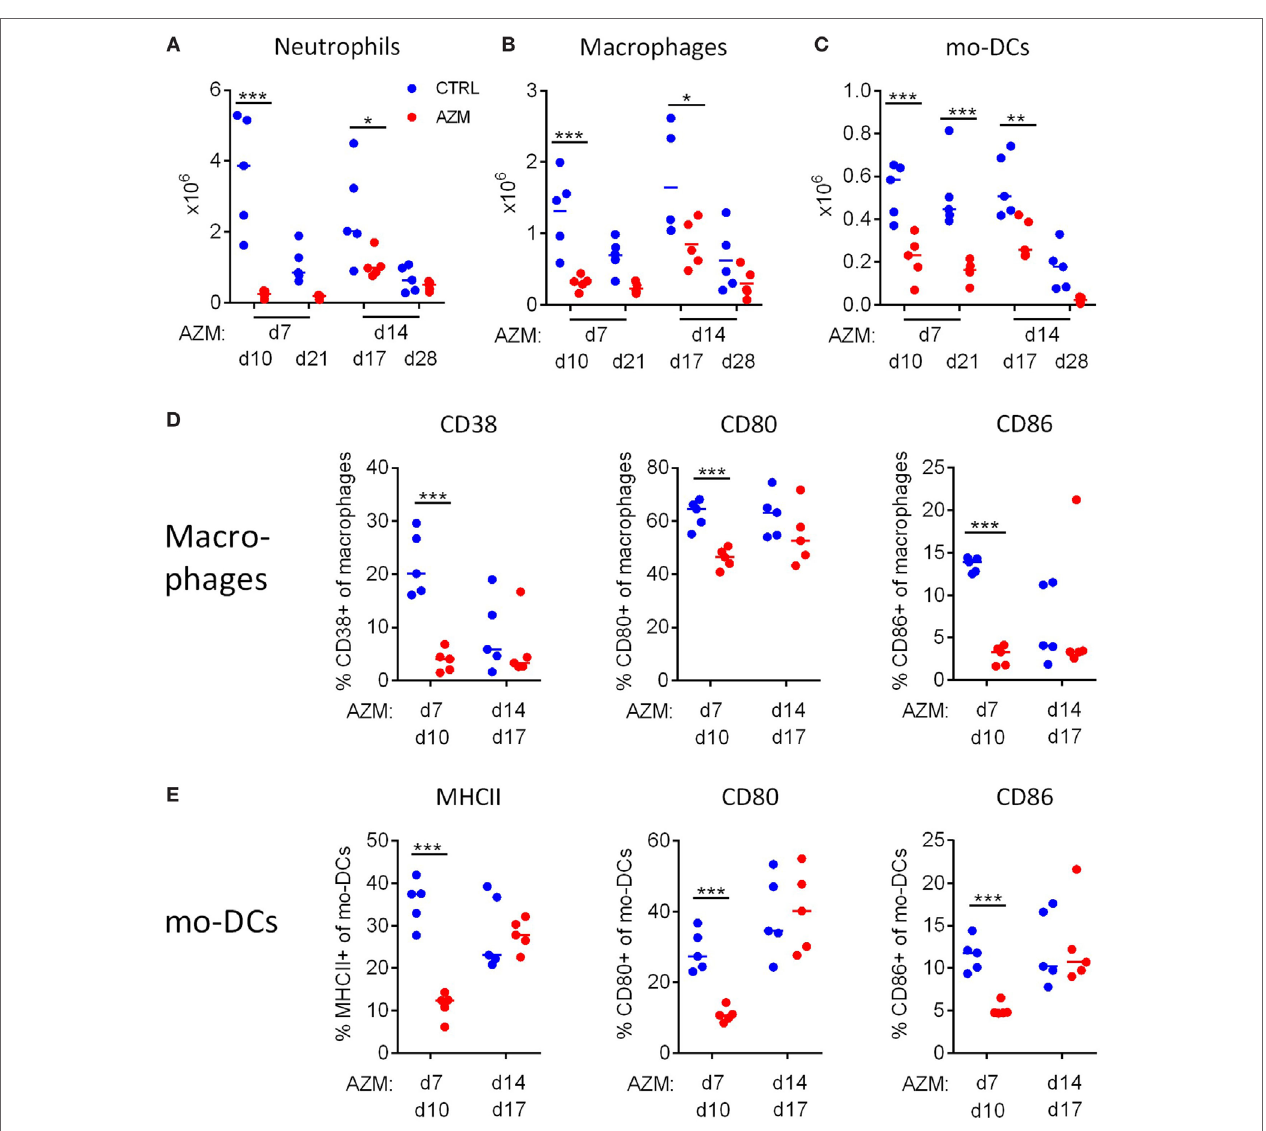
FigUre 2 | Azithromycin (AZM) treatment early in infection modulates innate immune responses in the lungs. Innate immune cell composition in lung digests were characterized by flow cytometry and absolute cell counts were calculated. Neutrophils were described as SiglecF − B220 − Ly6C + Ly6G + (a) , macrophages